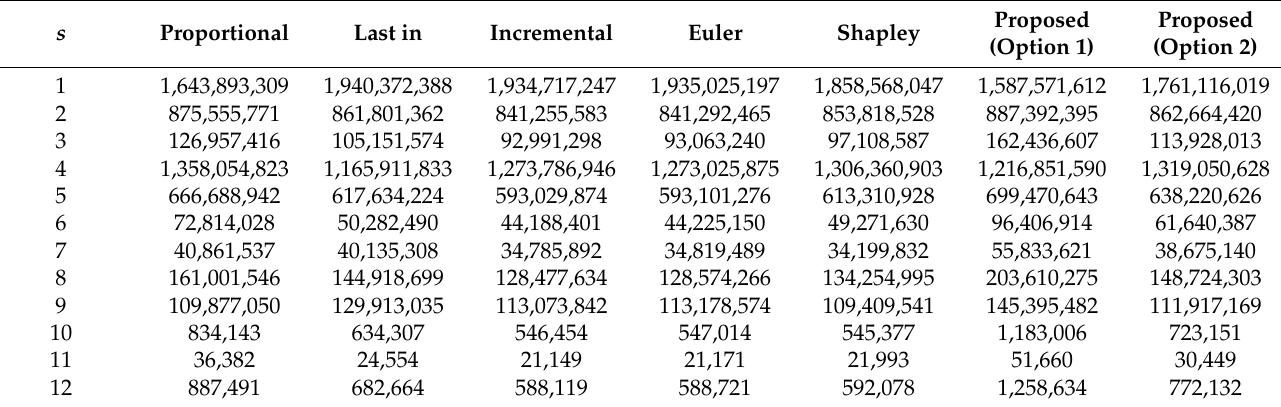
Table 5. Capital allocated to each segment under different